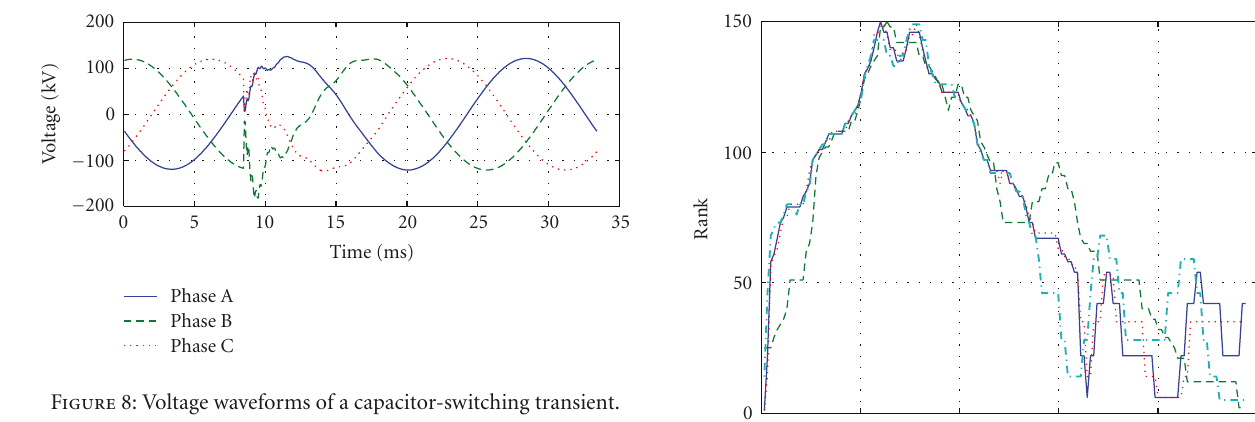
Figure 8: Voltage waveforms of a capacitor-switching transient.